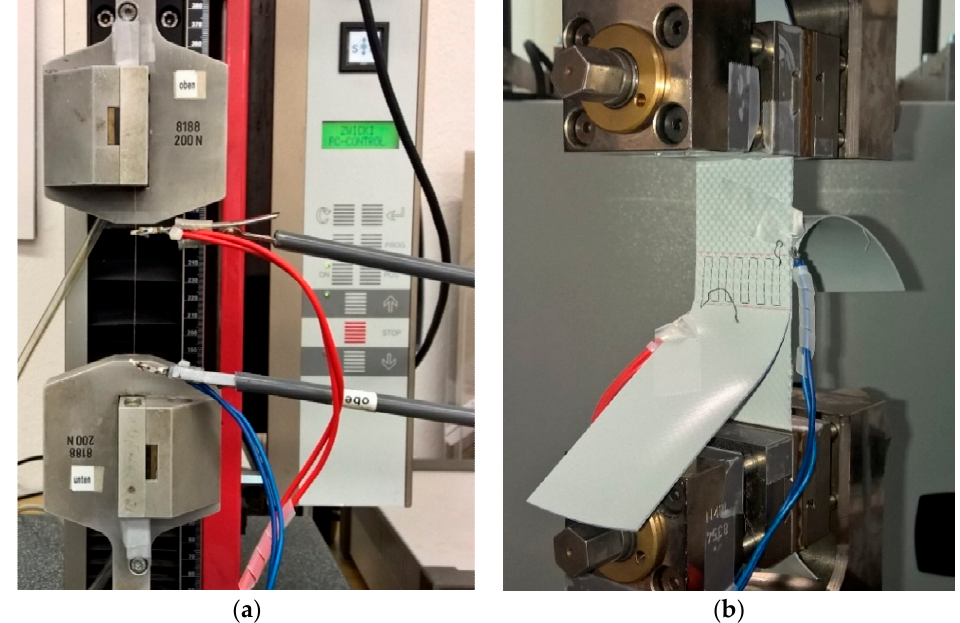
Figure 3. ( a ) The experimental set-up including measuring cables (blue and red) to determine the electromechanical properties of the sensor yarns and ( b ) a welded membrane specimen equipped with a sensor. Table 3. Process parameters of the investigations on the electromechanical properties of sensor yarns and textile strain sensors [24,25] Yarn Tensile Test Shear Test of Welded Membrane Basic standard DIN EN ISO 2062 ASTM D7747/D7747M Measurement device (mech.) Zwick Z2.5N1S Zwick Zmart.Pro Measurement device (el.)